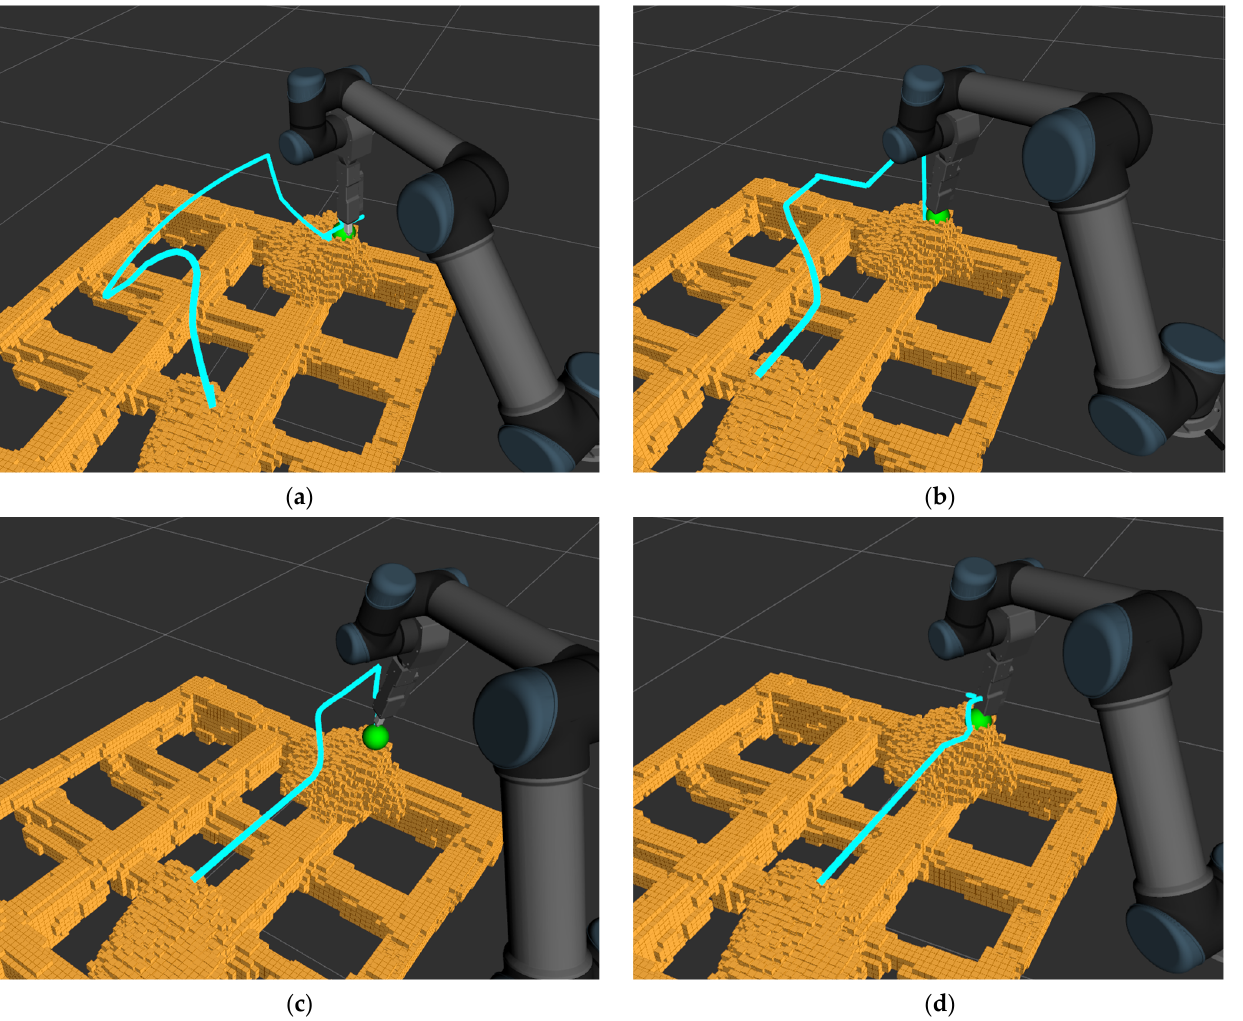
Figure 19. Different hammer tip trajectory paths of task 2 (same operator). The path is on a cyan line. ( a ) Conf. A (user controls each joint of the arm). ( b ) Conf. B (user controls the pose of the end-effector). ( c ) Conf. C (user controls the pose of the end-effector and 3D reconstruction of the environment) ( d ) Conf. D (user controls the pose of the end-effector, 3D reconstruction of the environment, and haptic feedback).